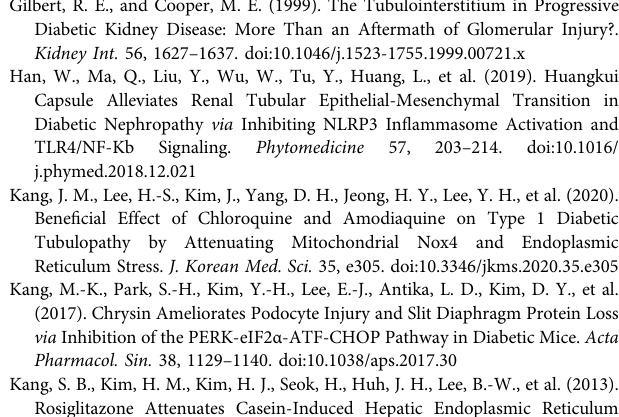
Supplementary Figure S1 | Fingerprint analysis of SKI by HPLC. (A) Chromatograms produced from mixed standards, (B) SKI samples. Abbreviations: SKI, Shenkang injection; HPLC, high performance liquid chromatography. Supplementary Figure S2 | Animal experimental protocols. Supplementary Figure S3 | Cell viability in cultured NRK-52E cells. (A) Cultured NRK-52E cells were exposed to HG with SKI at 10, 20, and 40 μ g/ml for 24 h; (B) Cultured NRK-52E cells were exposed to HG with ROS at 50, 100, and 200 nmol/L for 24 h. Abbreviations: HG, high glucose; ROS, rosiglitazone; SKI,